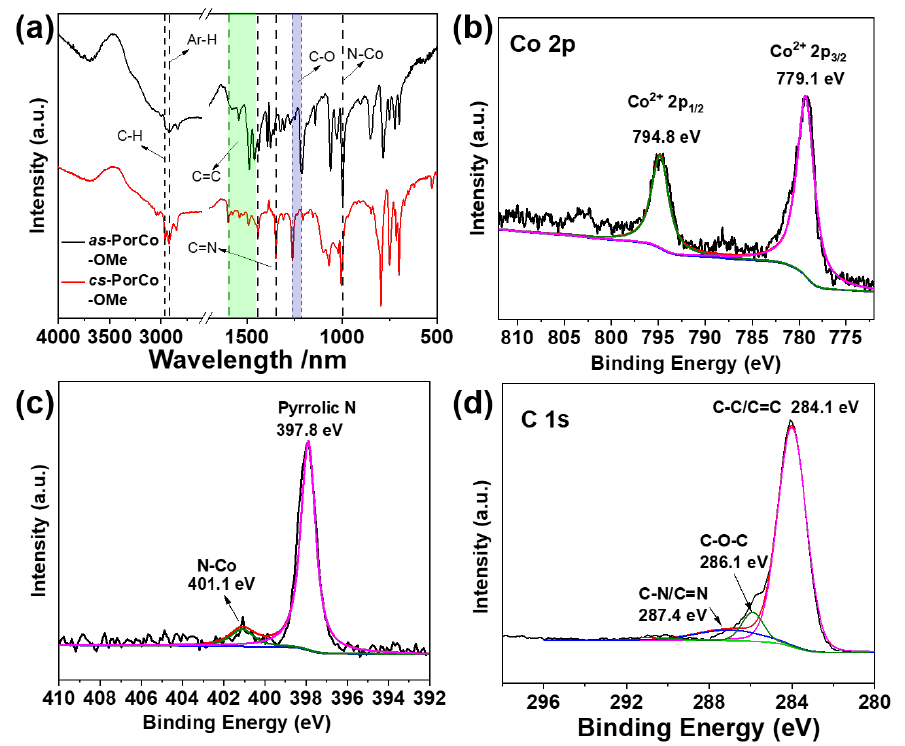
Molecules 2023 , 28 , x FOR PEER REVIEW 5 of 12